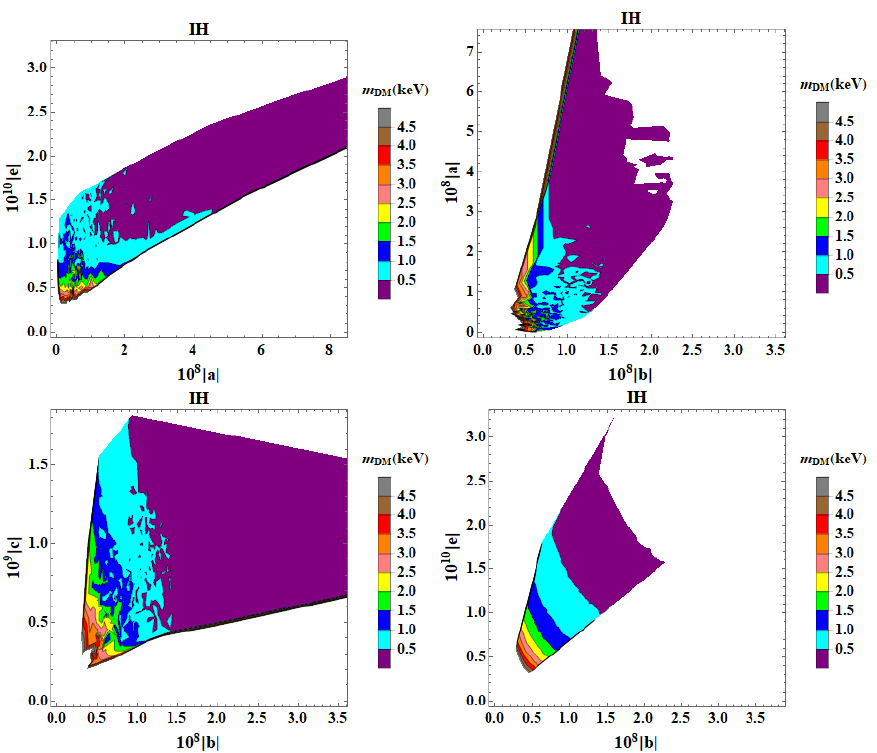
Figure 7 . Variation of di(cid:11)erent model parameters (in eV) with Dark Matter mass as a contour for inverted hierarchy The mass limit as predicted by cosmology is (0 : 4 (cid:0)